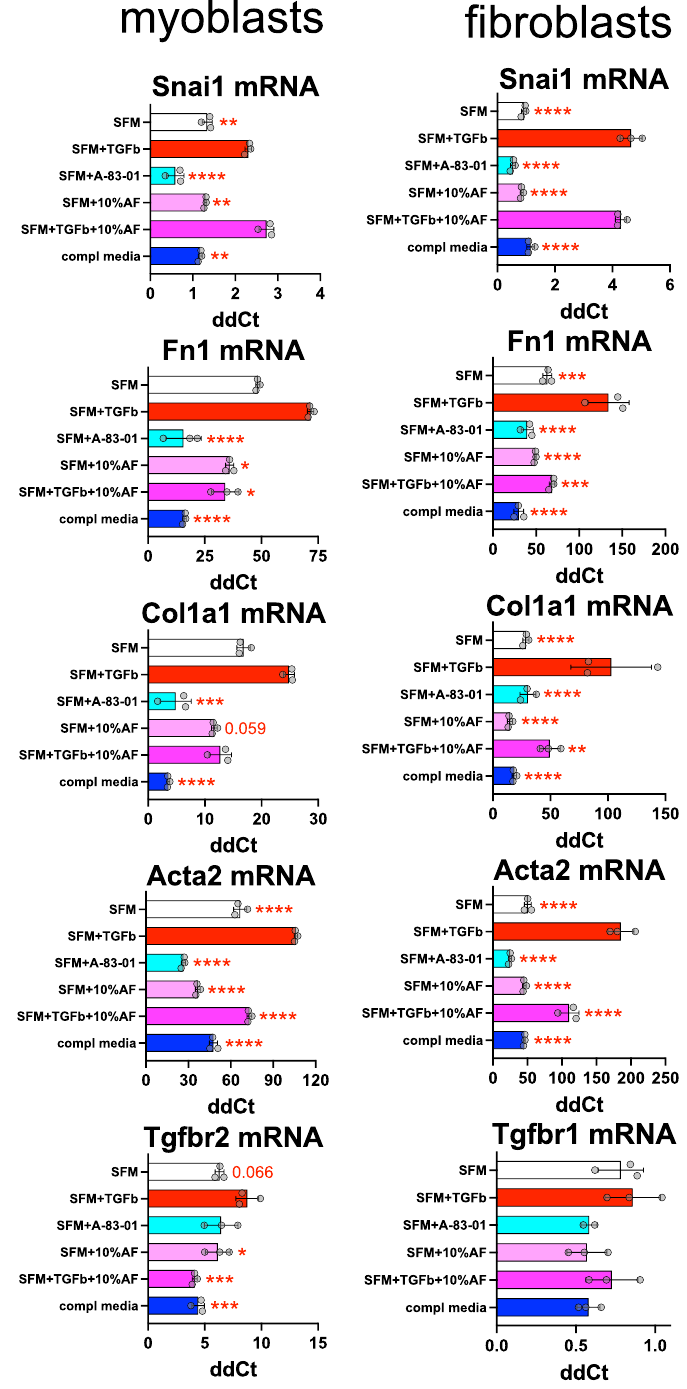
Figure 5. AF represses TGF-ß-activated EMT and MFA. RT-qPCR of extracts from myoblasts (left) or fibroblasts, measuring mRNA from Snail1 , Fn1 , Col1a1 , Acta2 and Tgfbr2 relative to Hmbs mRNA. The cells were cultured in biological triplicate using the following media conditions: SFM, SFM + 5 ng/mL TGF-ß, SFM + A-83-01 (a TGF-ß inhibitor), SFM + 10% AF, SFM + TGF-ß and 10% AF or complete media for 24 h then the RNA was extracted and analyzed. Error bars represent the SD from the mean ddCt values (* p < 0.05, ** p < 0.01, *** p < 0.001, **** p < 0.0001 by one-way ANOVA are shown (and in some cases the p -value) compared to the SFM + 5 ng/mL TGF-ß